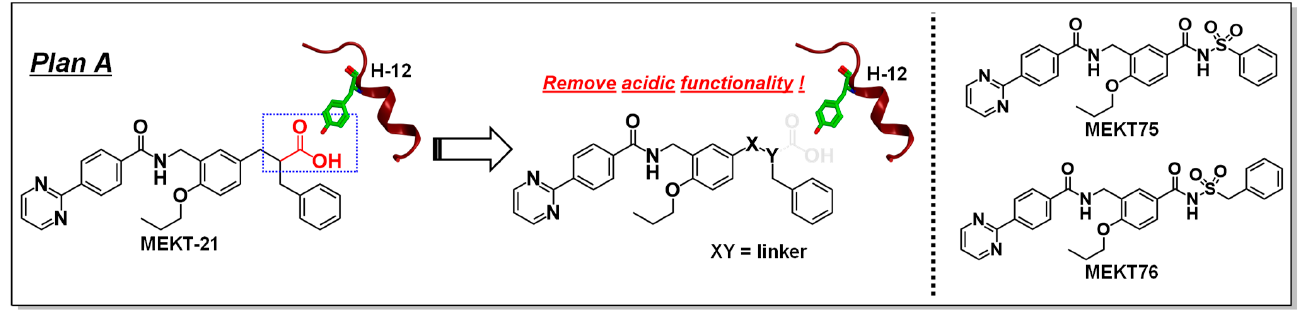
Figure 1. The strategic plan A to create hPPAR γ antagonists.